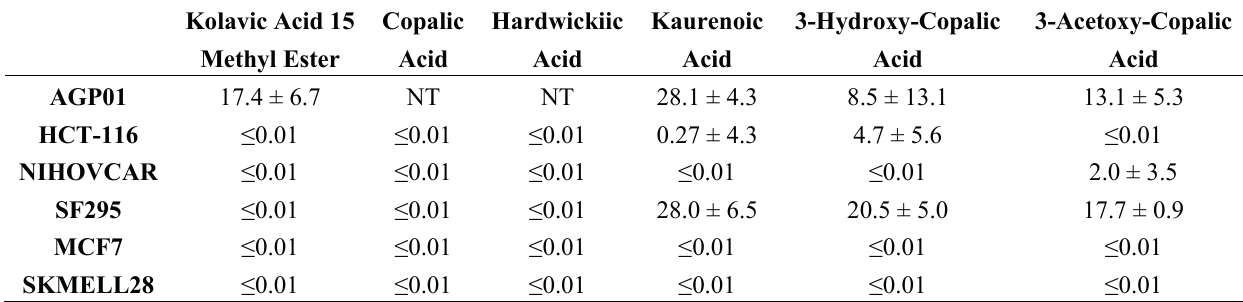
Table 1. Viability inhibition (%) of diterpenes from Copaifera spp. in tumoral line cells after 72 h of exposition at 20